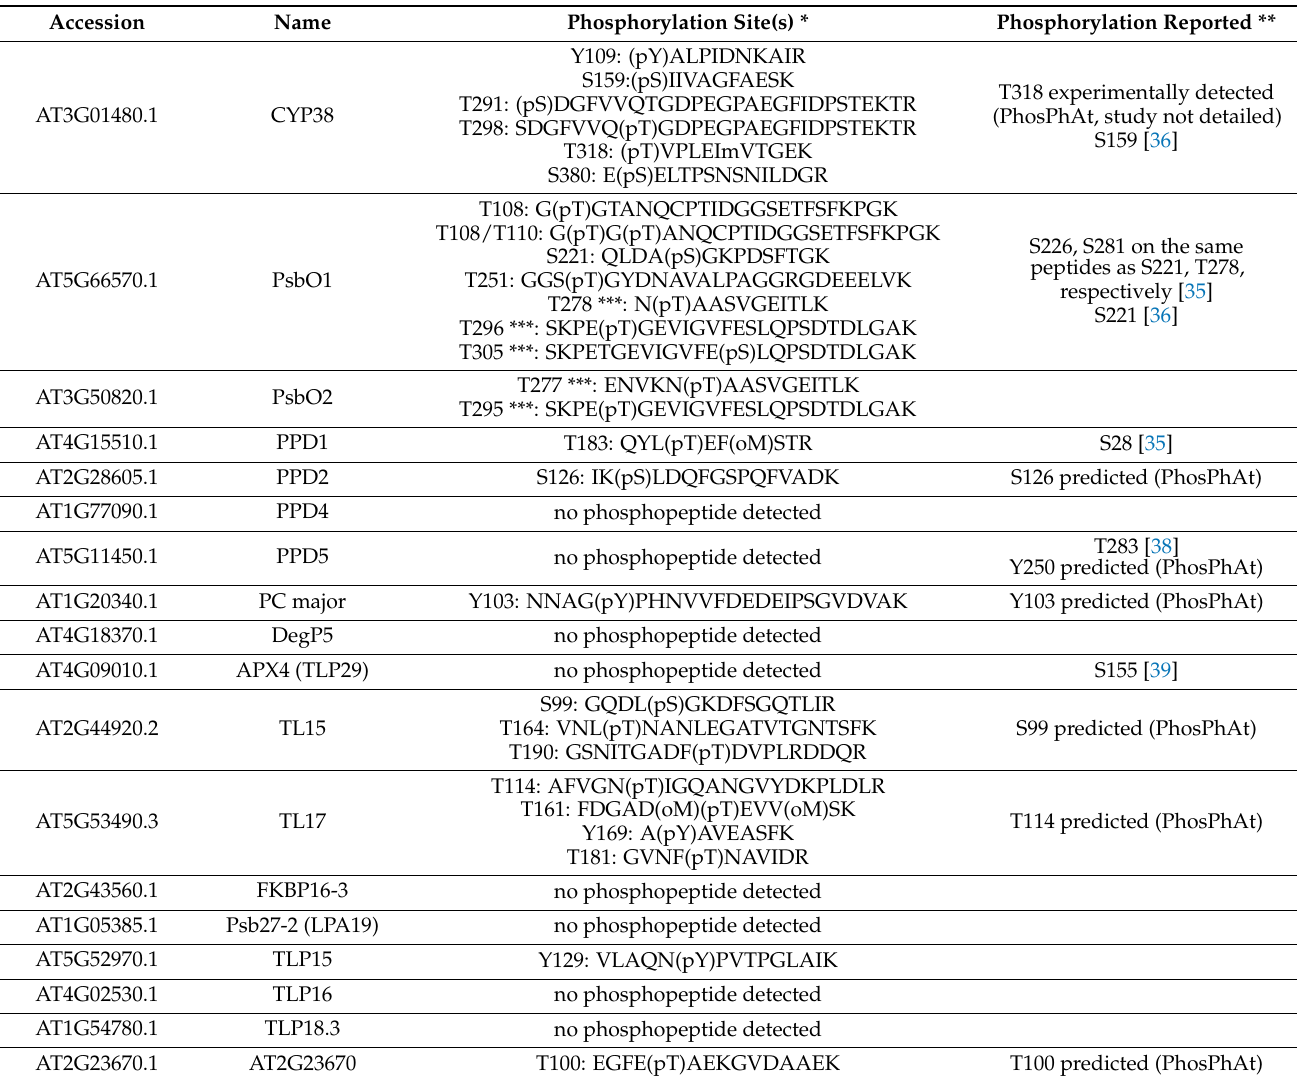
Table 2. Mass spectrometry-based identification of proteins isolated by bi-dimensional clear native PAGE, including phosphorylation